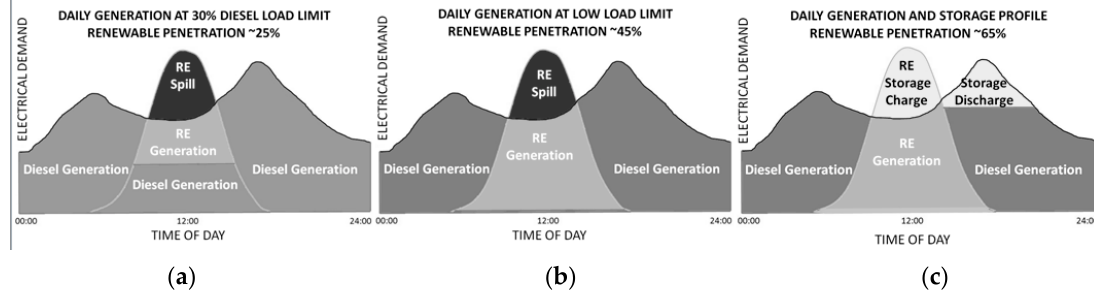
Figure 1. Typical electrical demand [black line], diesel generation [dark grey area], renewable generation [grey area], energy storage [light grey area] and renewable spill [black] for cases ( a ) to ( c ). Case ( a ) represents a standard 30% diesel load limit, Case ( b ) low load diesel, and Case ( c ) low load diesel plus energy storage applications. Note the increasing share of renewable penetration across ( a ) to ( c ). A solar PV RE resource is shown for illustrative purposes above.